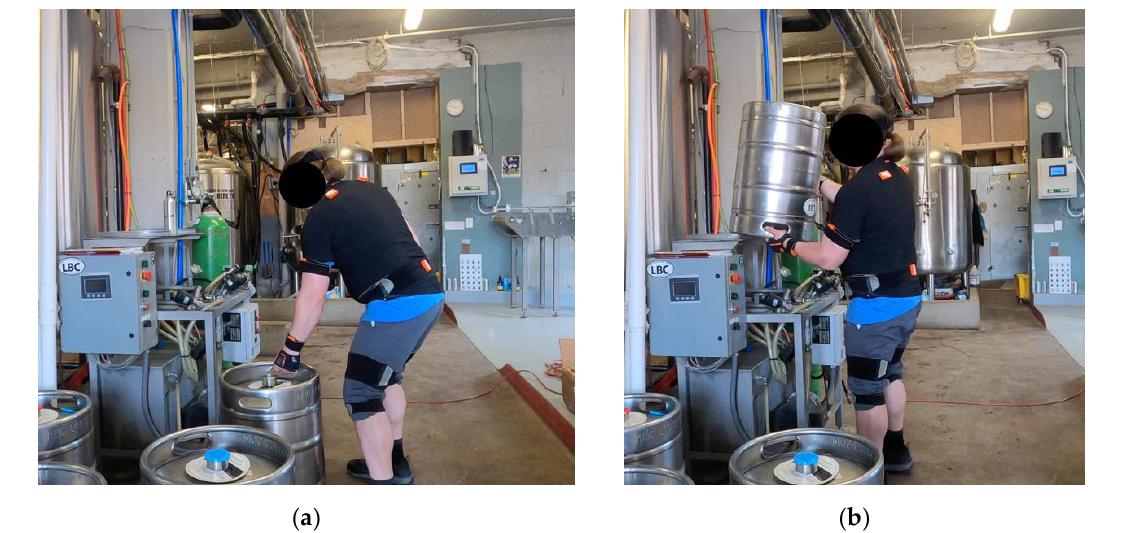
Figure 2. Task#1: Lifting an empty beer keg from the floor and placing it on a keg cleaner: ( a ) Pose#1;